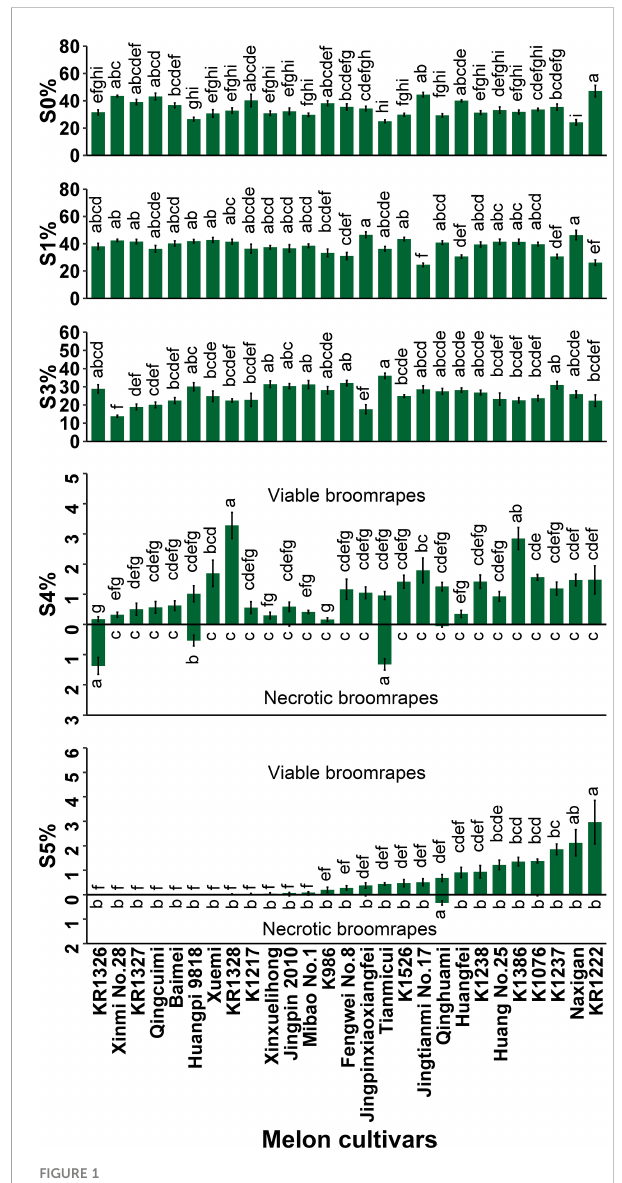
FIGURE 1 Percentages of P. aegyptiaca at different growth stages on roots of 27 melon cultivars at 35 DAI. S0, P. aegyptiaca seeds were not germinated; S1, seeds germinated but failed to attach to the melon roots; S3, seedlings had fi rmly adhered to or penetrated the host roots but had not formed a vascular connection; S4, tubercle stage, the parasite had formed a vascular connection to the host roots; S5, the “ spider ” stage (tubercles with secondary roots) ≤ 1cm. Vertical bars represent the mean ± SE, while letters represent mean separation at P ≤ 0.05 by Tukey ’ s HSD test in each growth